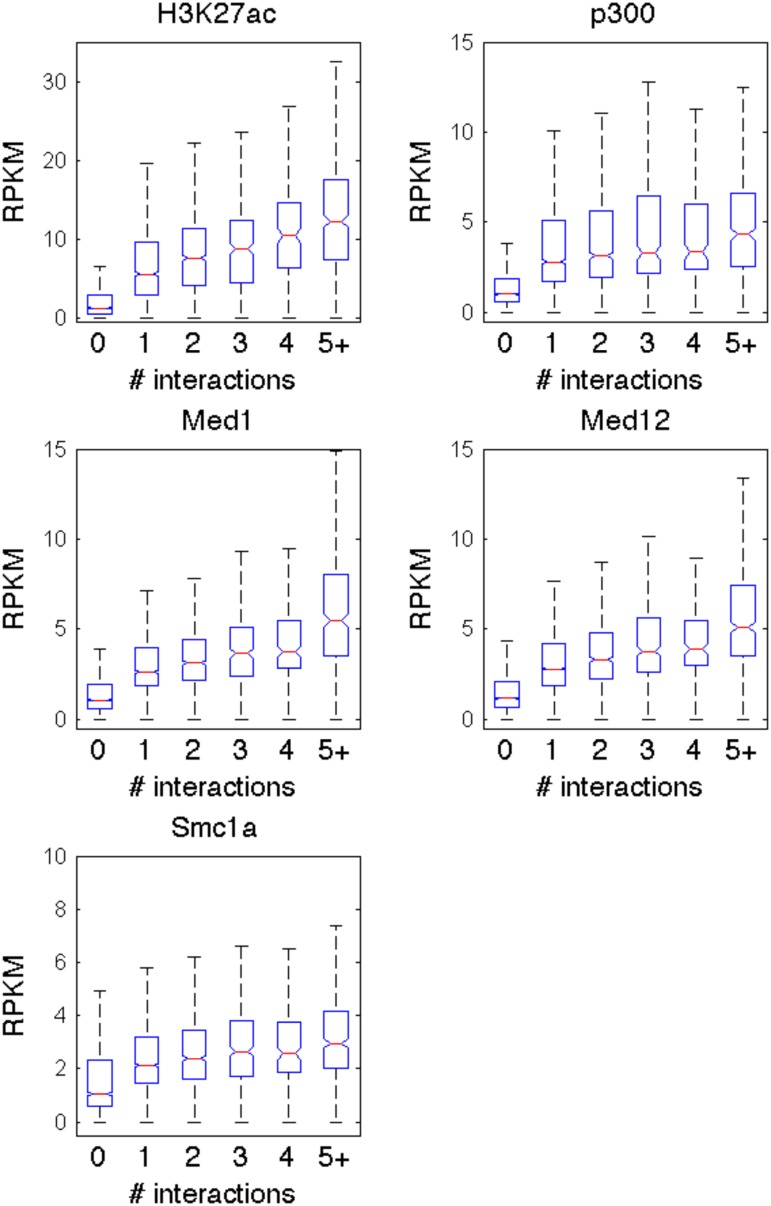
Enrichment for enhancer associated marks is correlated with the number of TSSs with which a nonTSS location interacts.All nonTSS locations that are involved in an interaction with a TSS in at least one of the cell types were considered. The nonTSS locations were categorized based on the number of TSSs that they interact with in ESCs. RPKM values were computed from ChIP-Seq data in 1 kb windows centered on each nonTSS location. The boxplots reflect the distributions of RPKM values for the nonTSS locations in each group for each ChIP-Seq dataset.